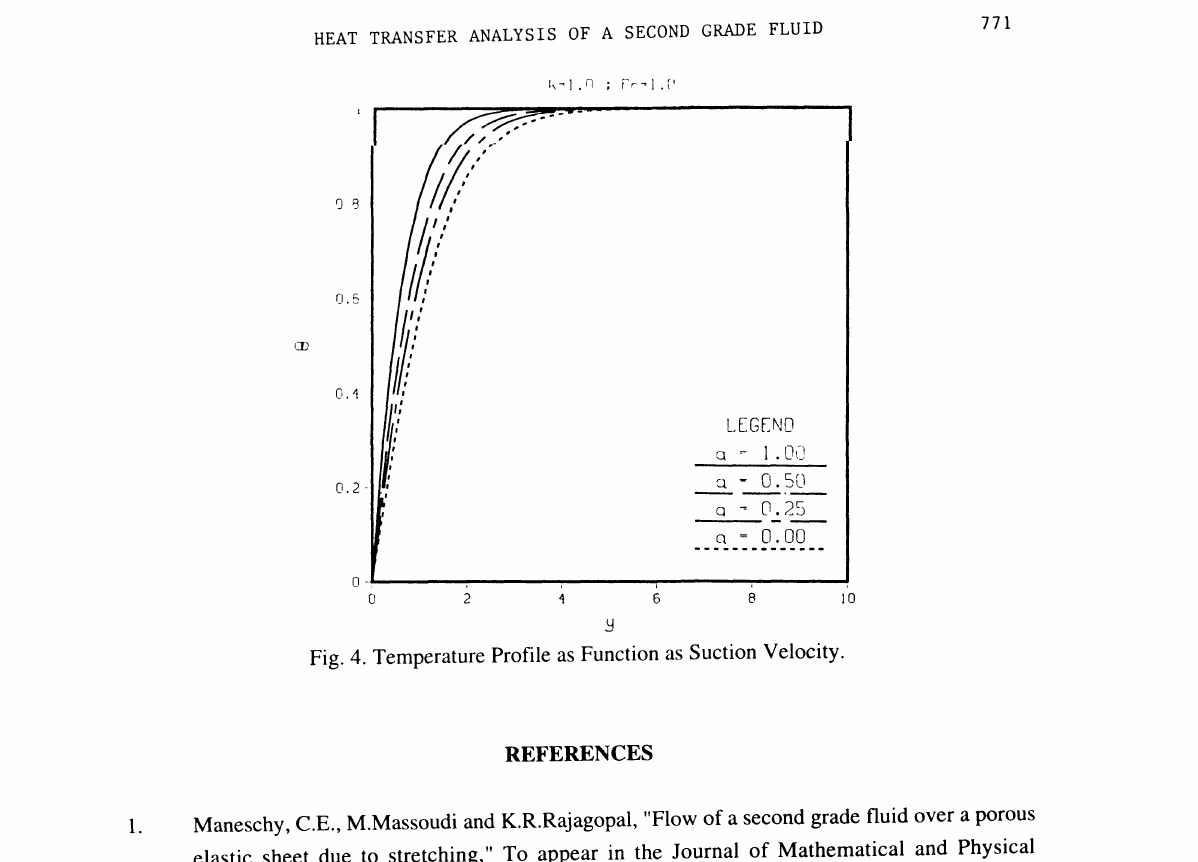
Fig. 4. Temperature Profile as Function as Suction